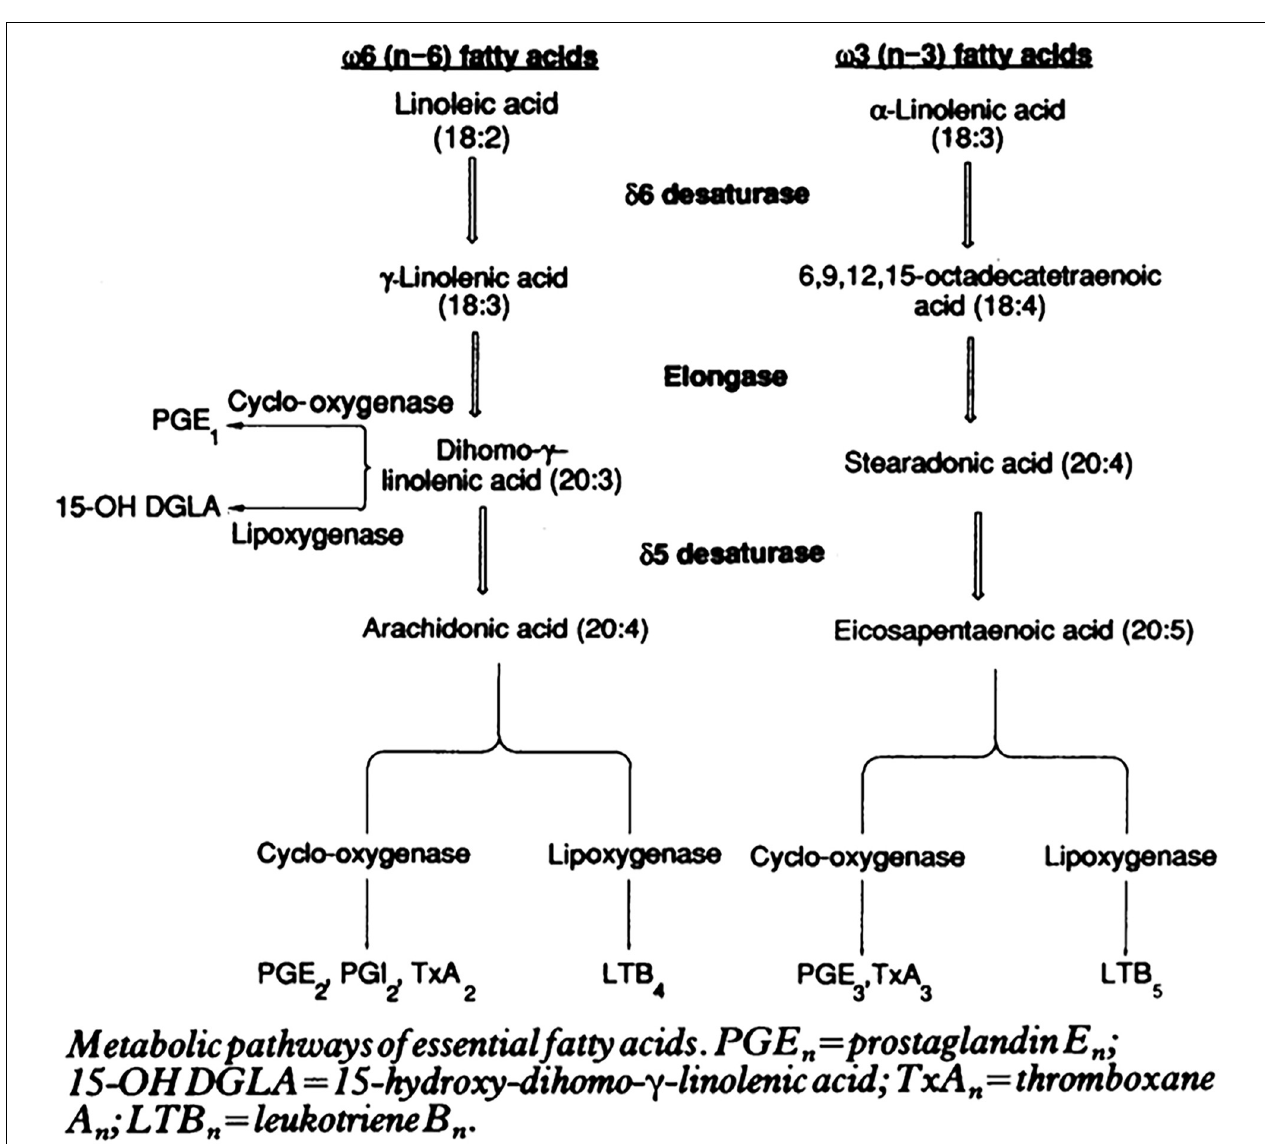
FIGURE 7 | Essential fatty acids in inflammation and potential “lipid storm” in severe COVID-19 patients. Scheme of eicosanoid and related bioactive lipid mediators production due to metabolic pathways of fatty acid alteration (eicosanoid related precursors). Reprinted from Zurrier (1991) with